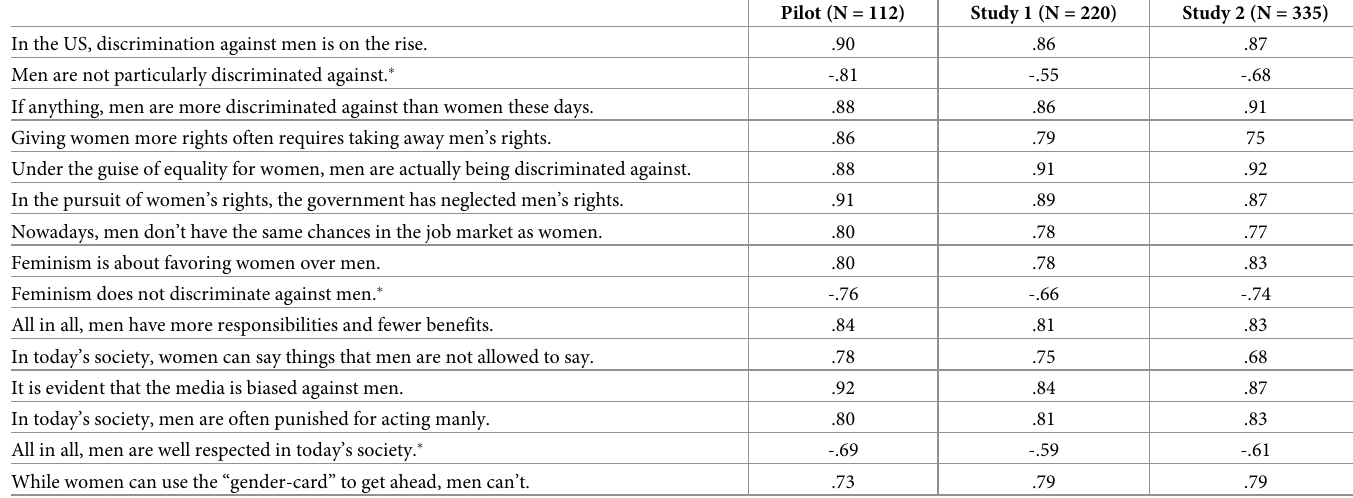
Table 4. Standardized component and factor loadings of the final BSS scale’s items by study.